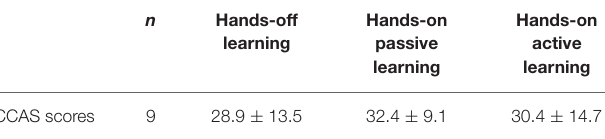
TABLE 2 | Combined student CCAS scores during different types of student-donkey